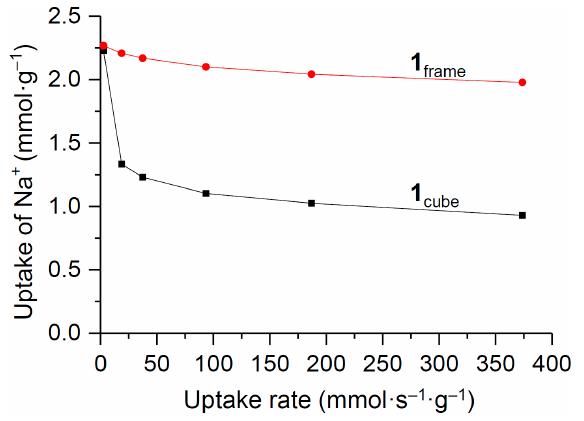
Figure 10. Uptake of Na + ions by 1 crystals at different uptake rates.